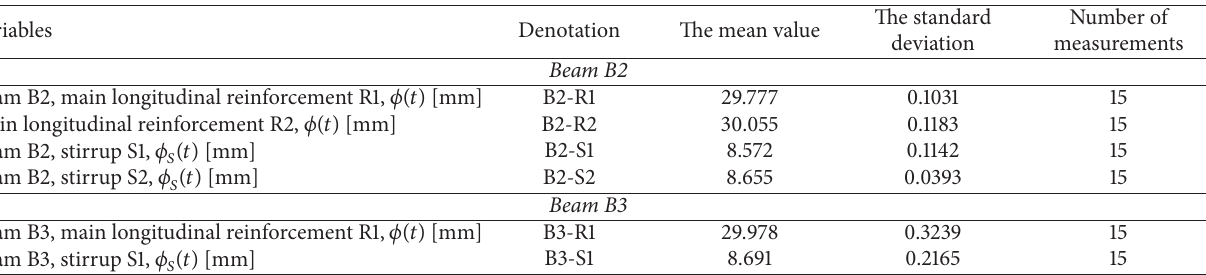
Table 3: Measured values of reinforcements’